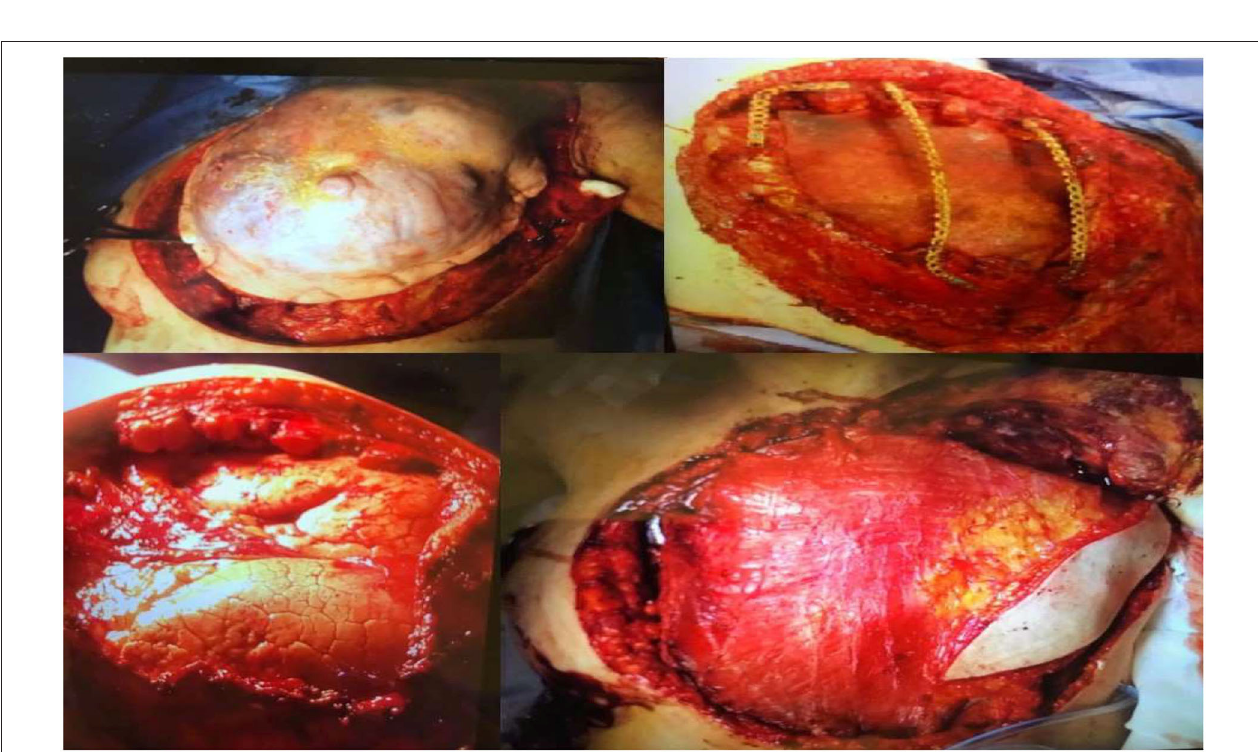
FIGURE 2 | Immuno-histochemical colorations and fluorescence in situ hybridization (FISH) of the bioptical specimen.